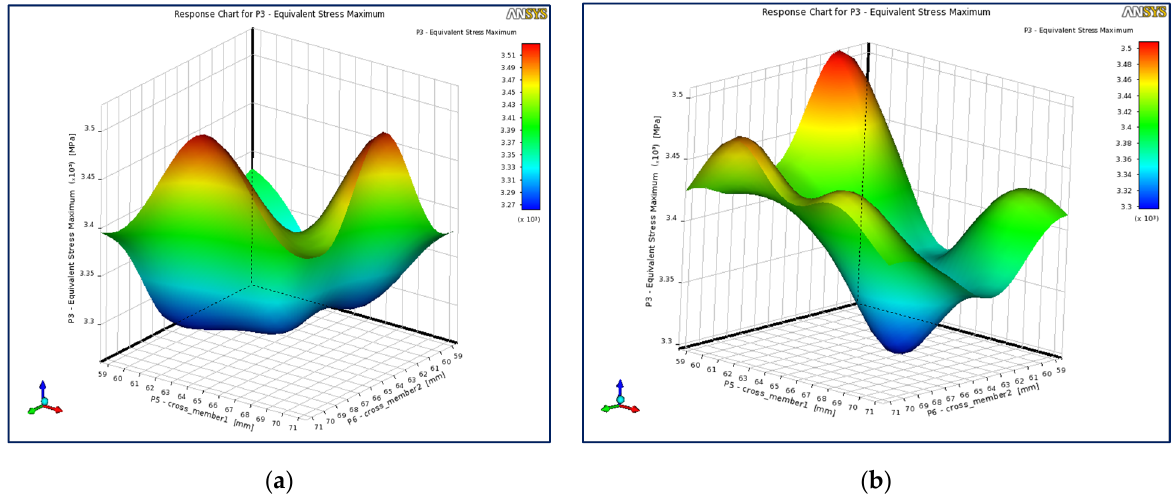
Figure 18. Response surface plot of equivalent stress vs. cross member 1 and cross member 2 ( a ) for CCD scheme, and ( b ) for optimal space filling (OSF) design.